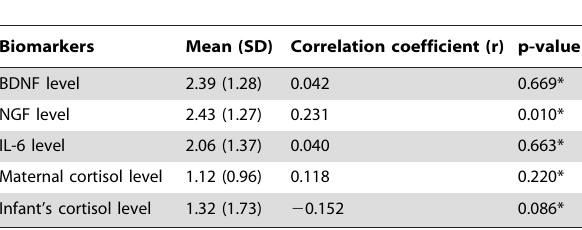
Table 2. Correlation analysis of biomarkers and infant motor development (AIMS Score).